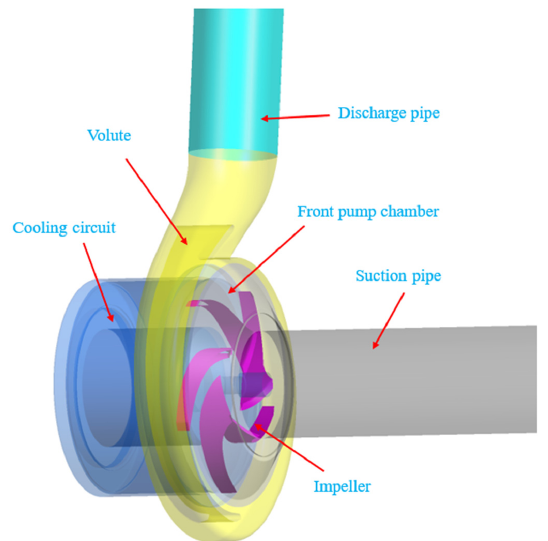
Energies 2023 , 16 , x FOR PEER REVIEW Figure 4. Computational domain of the magnetic drive pump. Figure 4. Computational domain of the magnetic drive pump.